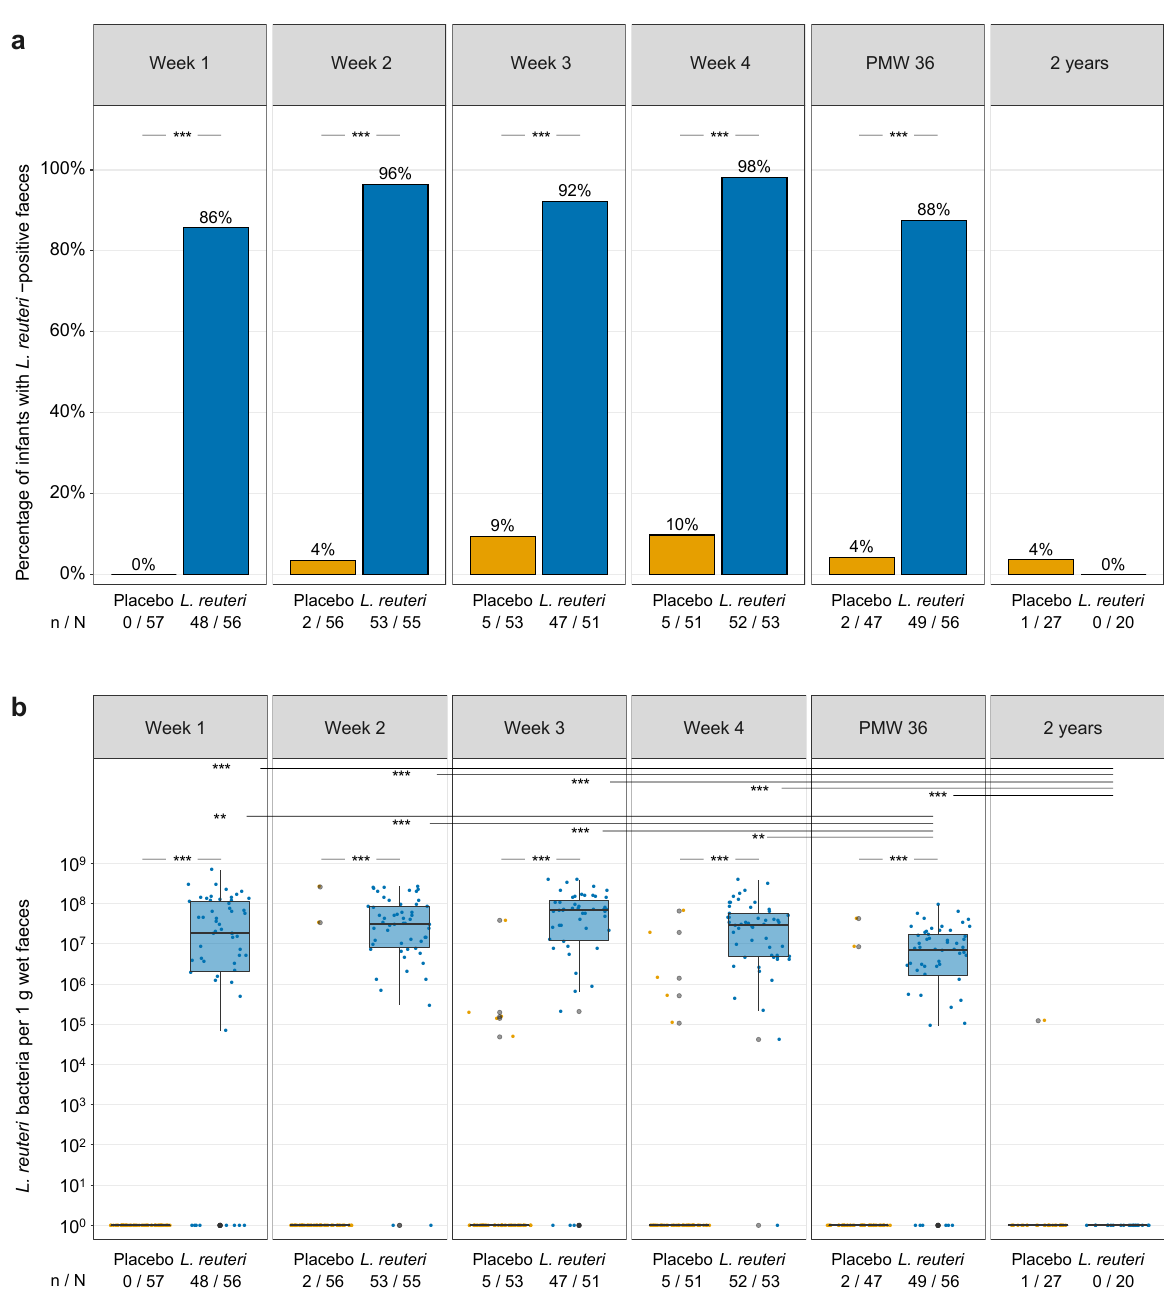
Figure 2. L. reuteri in faeces of the L. reuteri -supplemented and placebo group. L. reuteri prevalence ( a ) and abundance ( b ) in faeces of extremely preterm ELBW infants. Prevalence is expressed as the percentage of infants with a L. reuteri - positive faecal sample. Abundance is shown as the number of L. reuteri bacteria per 1 g wet faeces. Boxplots show median with 25% and 75% percentiles and 1.5 × the interquartile range. Numbers (n / N) indicate the number of infants with a L. reuteri -positive faecal sample and the total number of infants per group. For graphical display, the number of L. reuteri bacteria per 1 g wet faeces in ( b ) was set to 10 0 for infants with L. reuteri -negative faeces. Statistics: Fisher’s